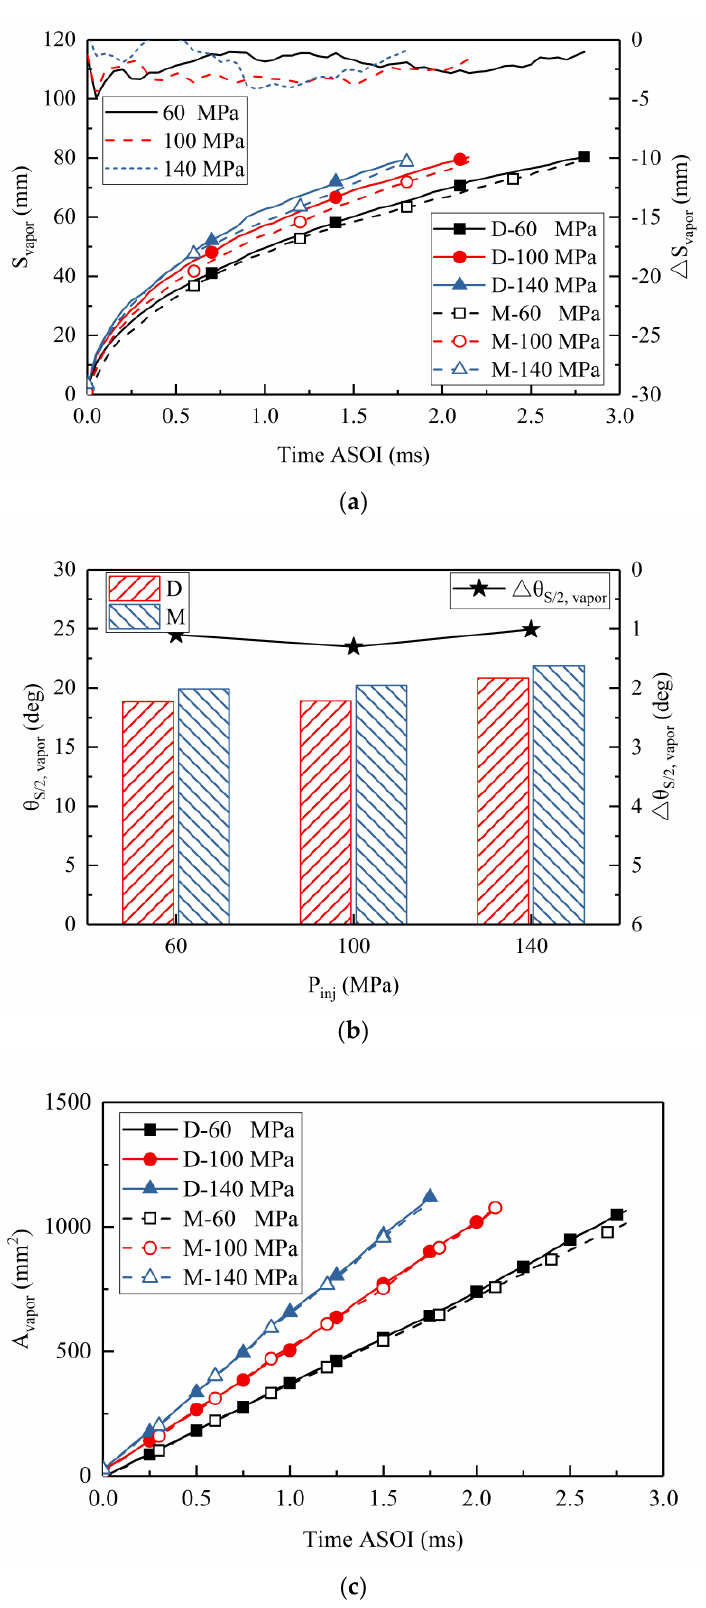
Figure 5. Quantitative results of the vapor phase spray under different injection pressure conditions. ( a ) Spray tip penetration results. ( b ) Spray angle results. ( c ) Spray area results.